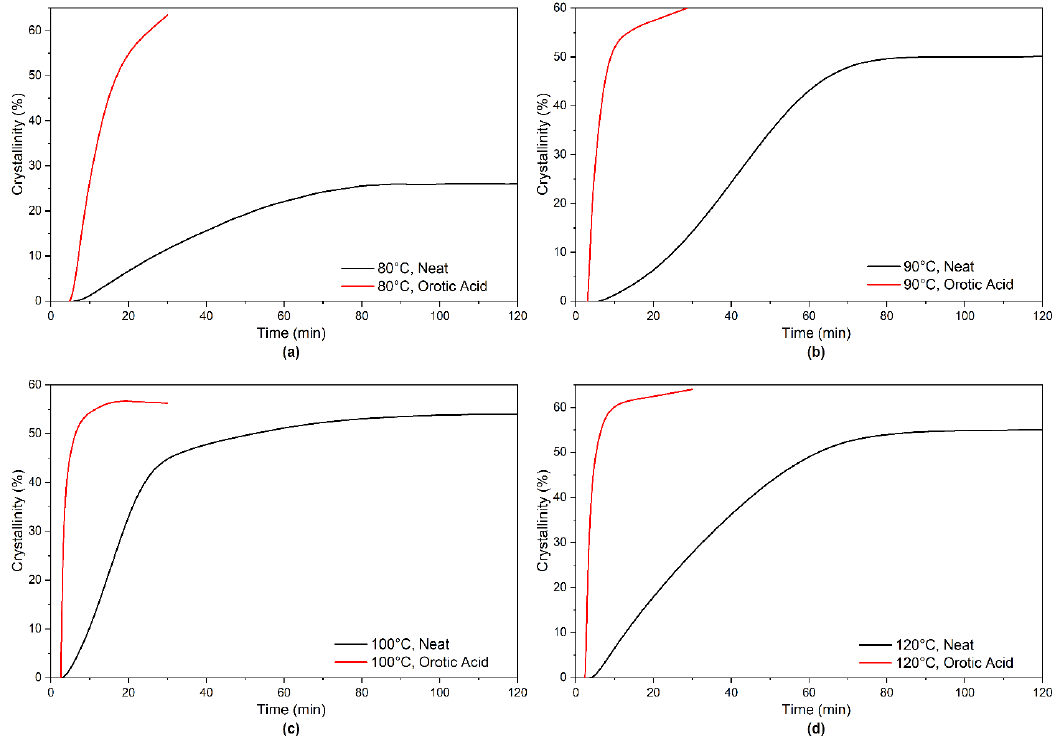
Figure 8. Crystallinity development curves of neat PLA and PLA-OA blend at 80 - 120°C.